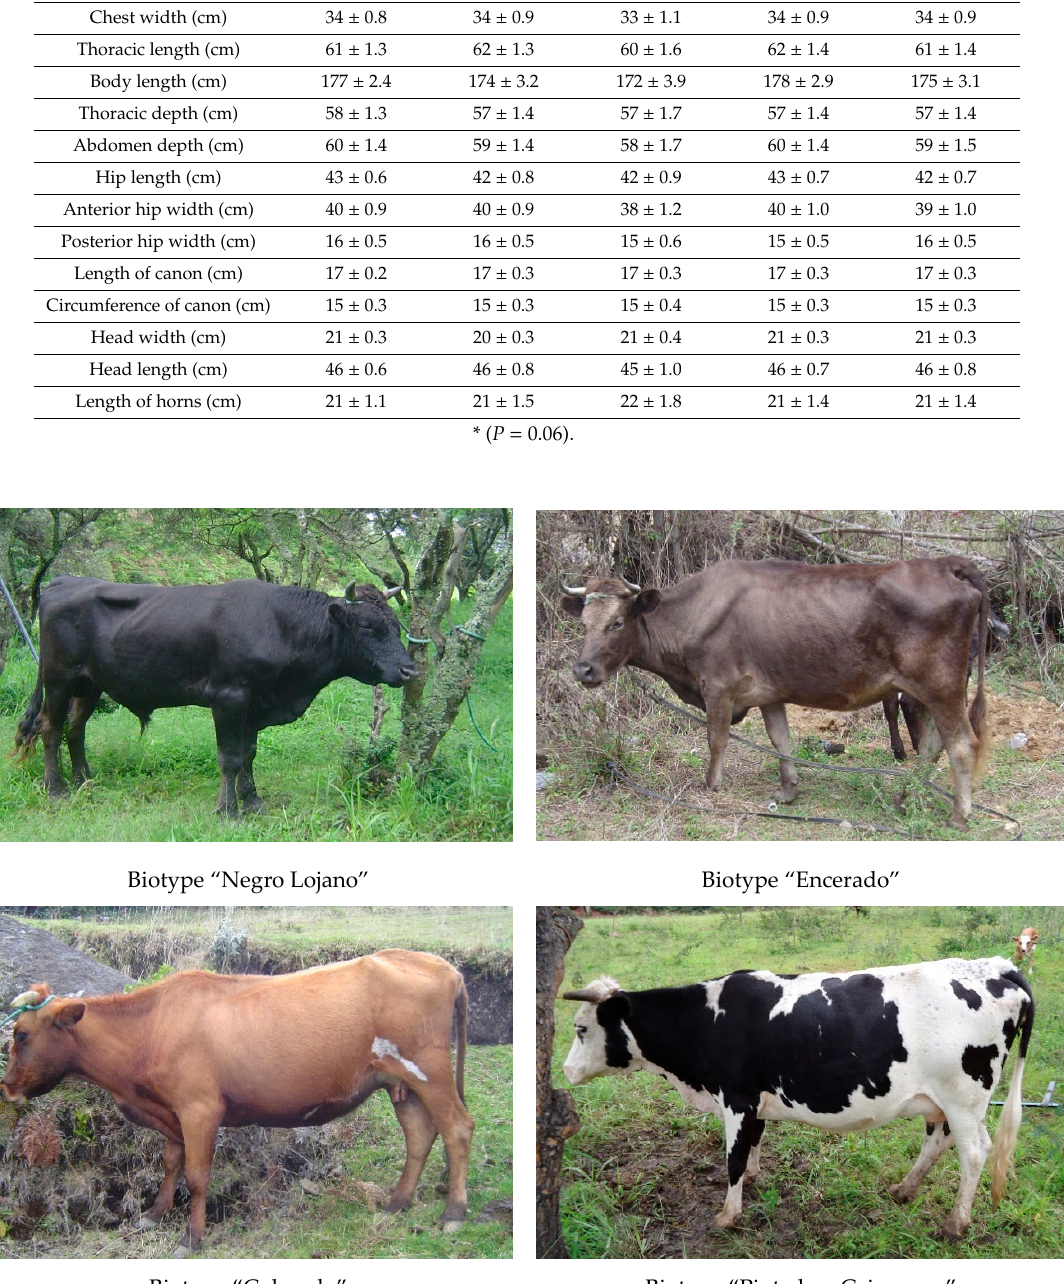
Table 3. Live weight and morphometric characteristics considering the sex of adult Criollo Lojano bovine (mean ± standard error).